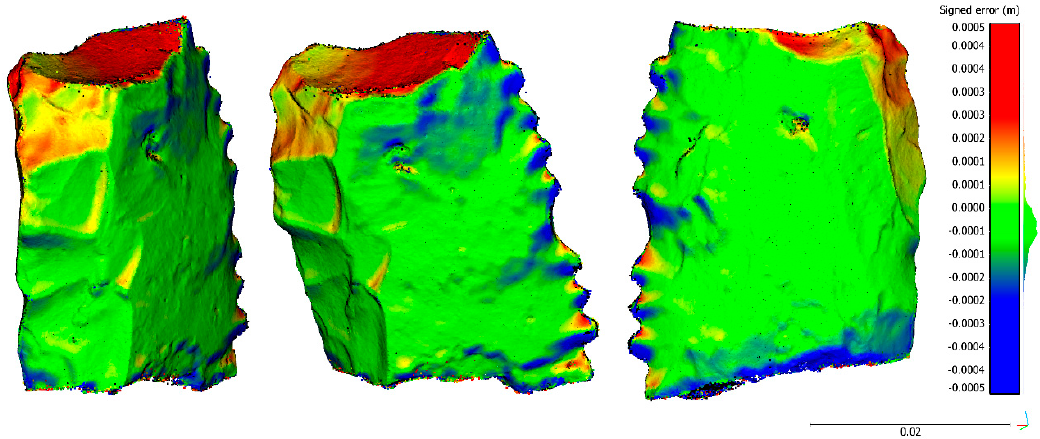
Figure 9. Different views of the spatial distribution of discrepancies between zoom lens reconstruction versus macro lenses for the specimen S3 (racloir): front view ( left ); diagonal front-right side view ( center ); and back view ( right ).